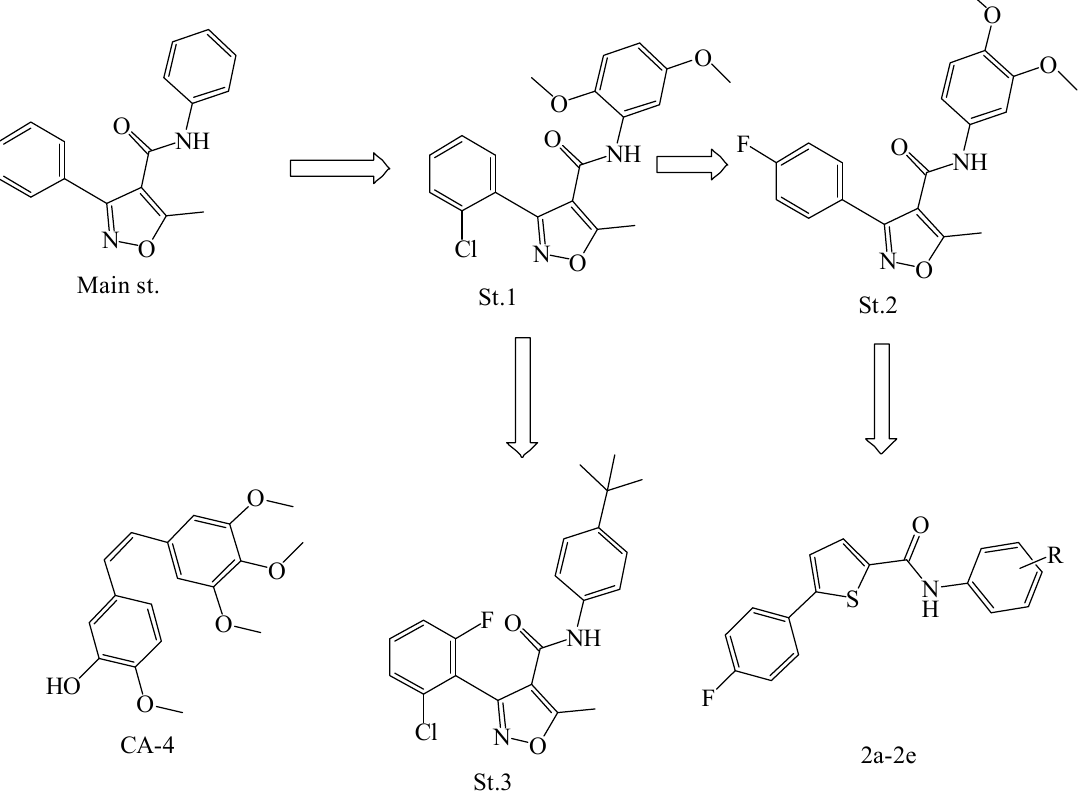
Figure 1. Chemical structures of CA-4, isoxazole-carboxamide series, and thiophene-carboxamide new series.